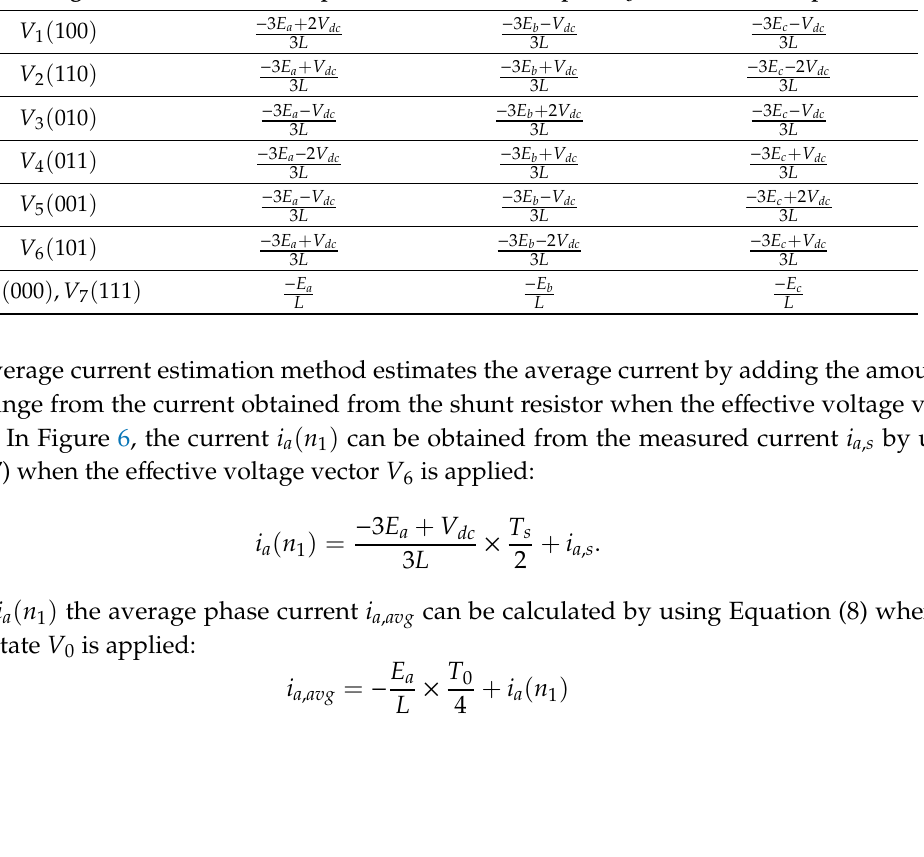
Table 2. Current slope according to the switching states.